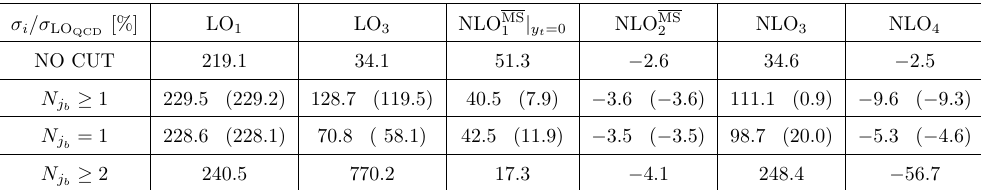
the rapidity region in which b -jets are tagged, | η ( j